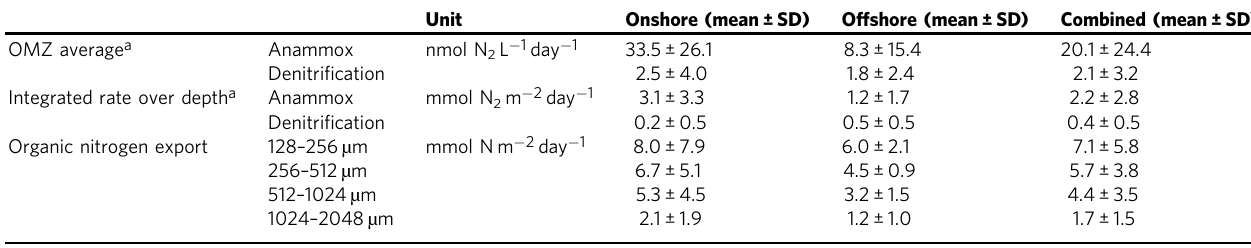
Table 1 Averaged and integrated anammox and denitri fi cation rates, and export of organic nitrogen out of the euphotic zone into the oxygen minimum zone (OMZ) from all sampled onshore and offshore stations (for more information refer to Supplementary Tables 1a and